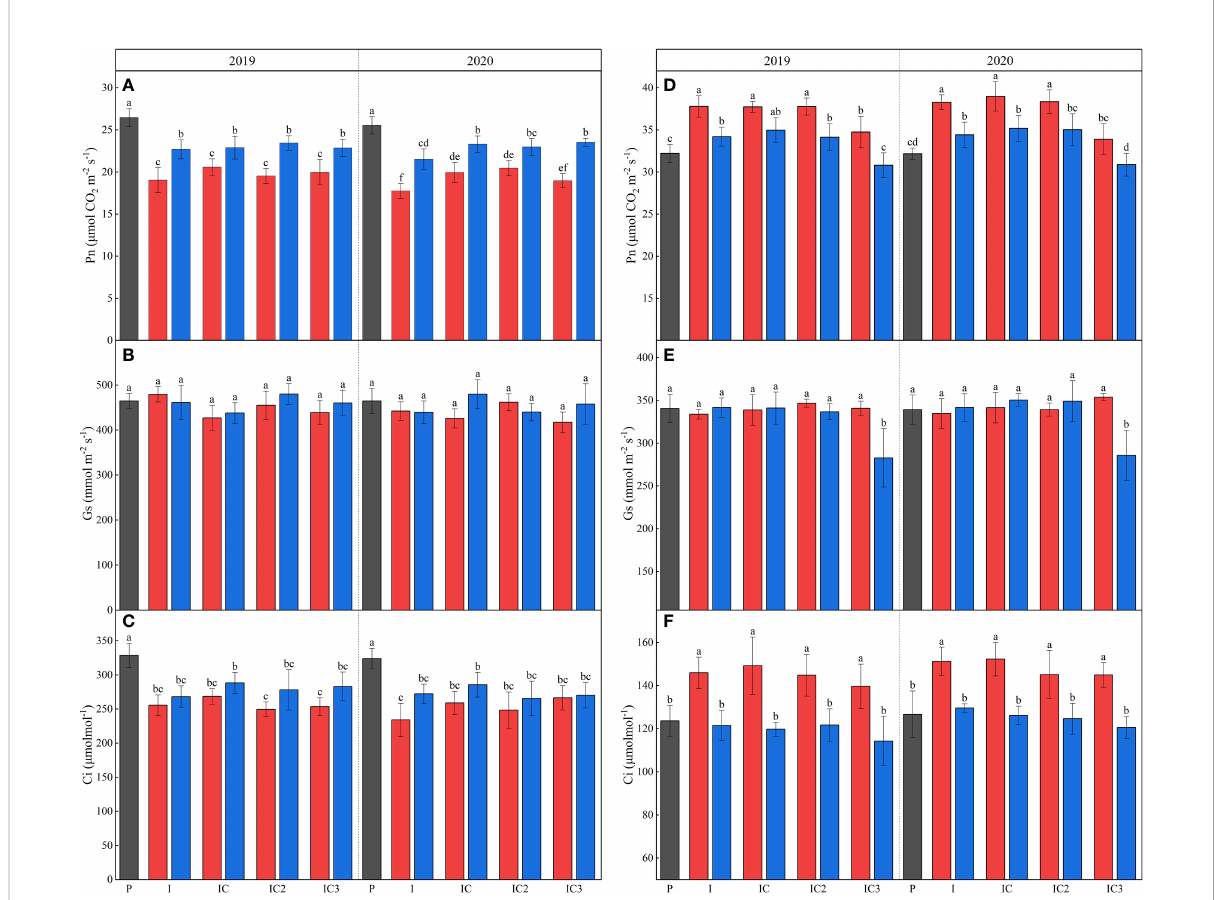
FIGURE 3 Pn (A, D) , Gs (B, E) and Ci (C, F) for peanut and maize in 2019 and 2020. P, sole peanut; M, sole maize; I, maize – peanut intercropping; RI, maize – peanut rotation – intercropping, RI2, 20% N reduction for maize of RI; ICN3, 40% N reductions for maize of RI. Different lowercase letters represent signi fi cant